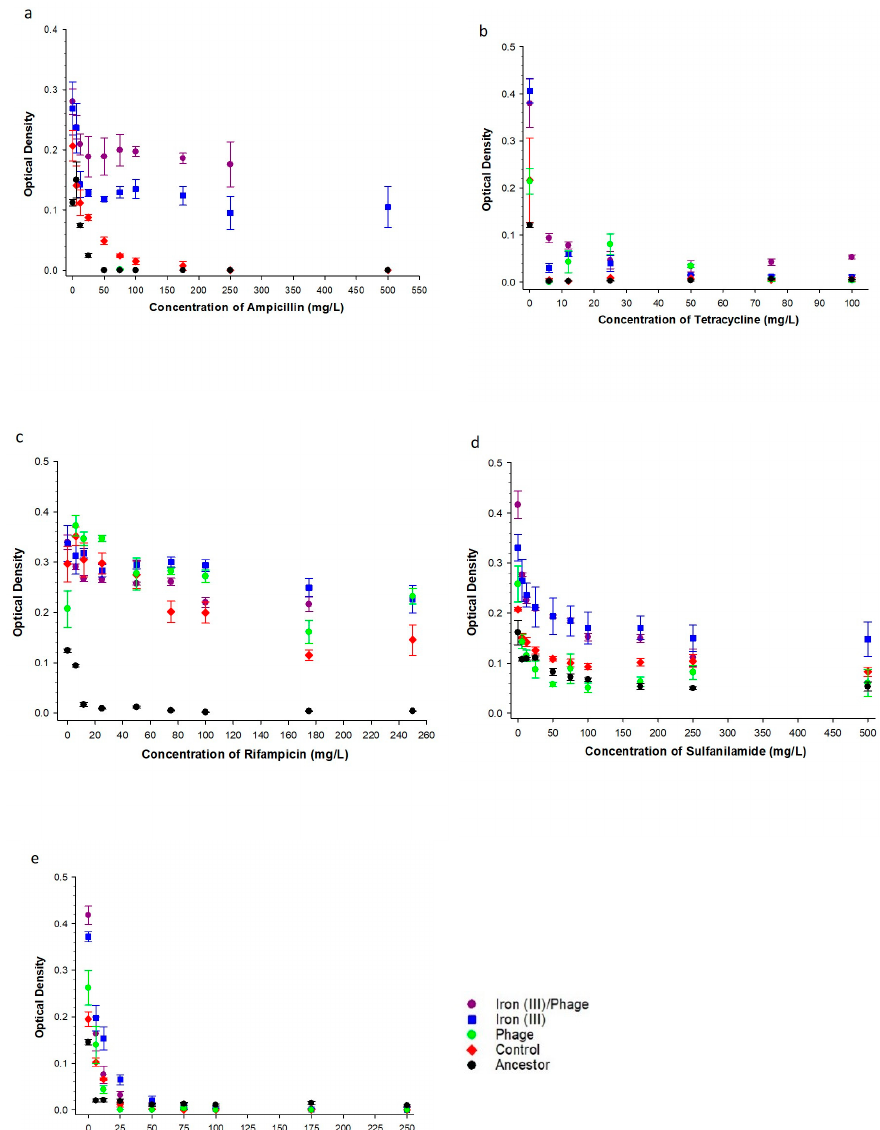
Figure 2. 24 h growth fitness in antibiotics. The mean and SE of 24 h growth for populations in increasing concentrations of ( a ) ampicillin to 500 mg/L, ( b ) tetracycline to 100 mg/L, ( c ) rifampicin to 250 mg/L, ( d ) sulphanilamide to 500 mg/L, ( e ) chloramphenicol to 250 mg/L. Growths were measured after 35 days of evolution in excess iron (III) and phage T7. With increasing rifampicin concentration (Figure 2c), iron (III)-resistant populations showed superior growth compared to iron (III)/phage-resistant populations. At the same time, there was no signi fi cant di ff erence between iron (III)-resistant compared to phage- resistant and iron (III)/phage-resistant compared to phage-resistant in increasing